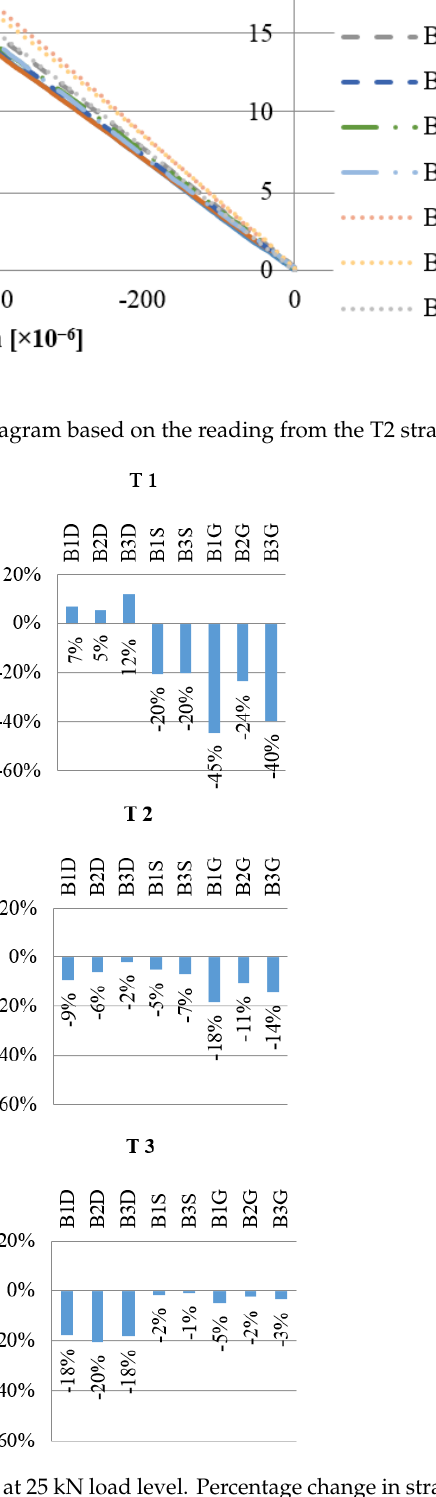
Figure 8. Readout from strain gauge at 25 kN load level. Percentage change in strain for different CFRP tape location in reference to bare beams (without reinforcement).